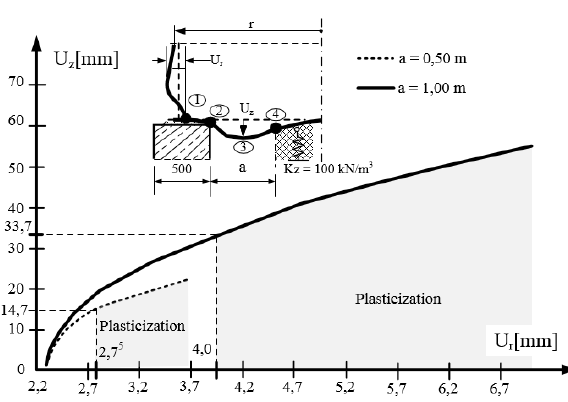
of bottom plates at the r